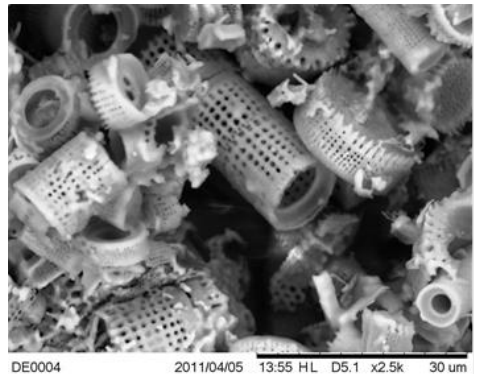
Figure 1. High-resolution image of diatomaceous earth surface under scanning electronic microscope. (Google: Diatomaceous earth images).